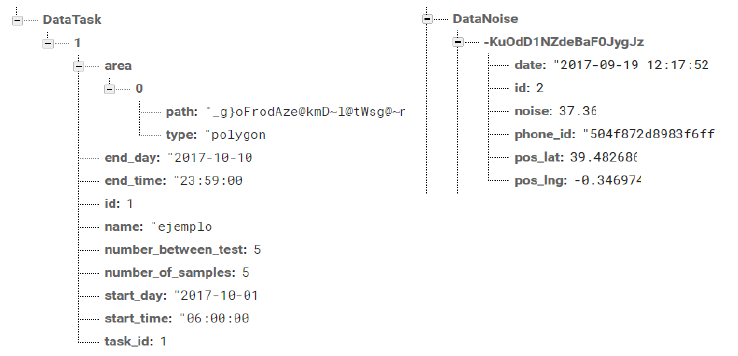
Figure 3. Format of a JSON data